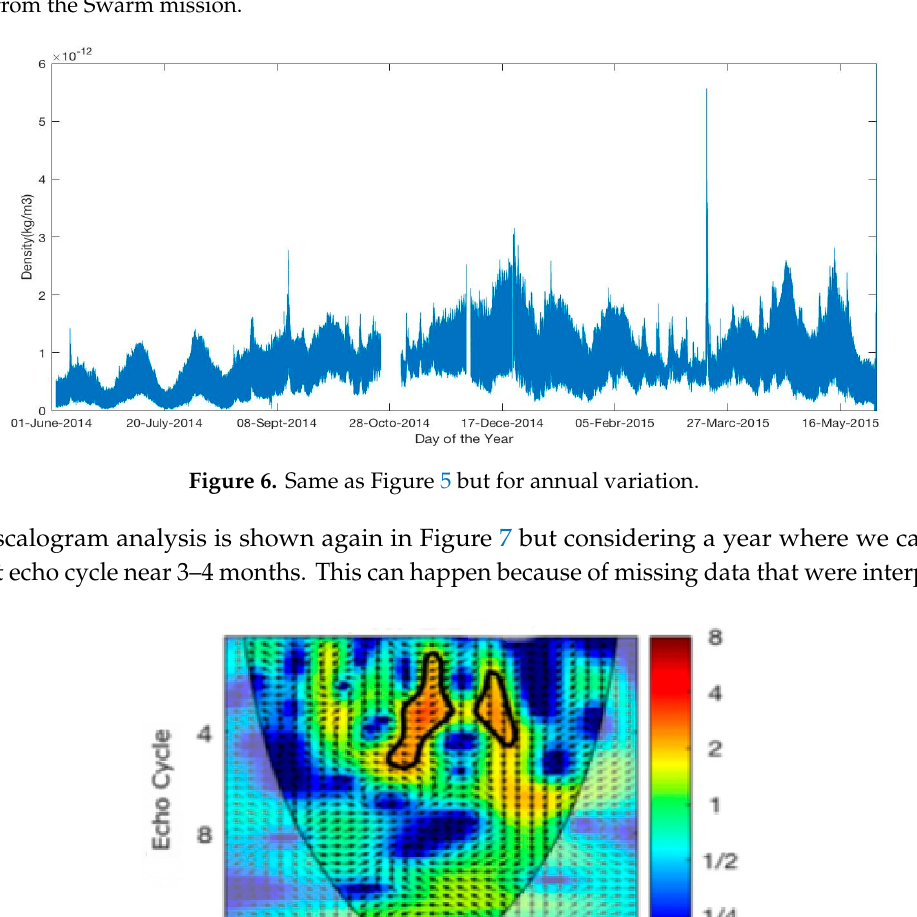
data from the Swarm mission.